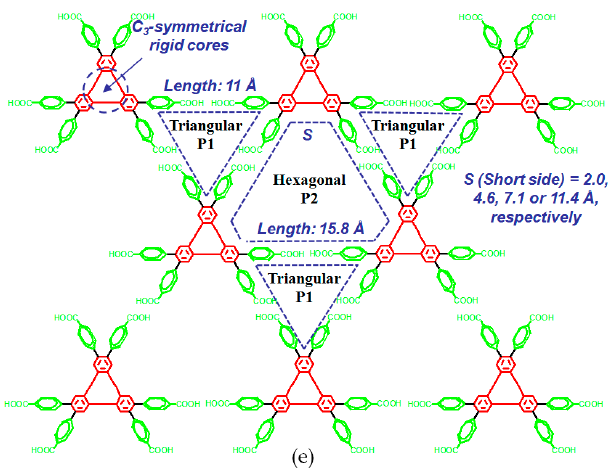
Figure 7. Structures of building motif 6a ( a ); 6b ( b ); 6c ( c ); and 6d ( d ); ( e ) Graphic representation of hydrogen bonded hexagonal sheets.